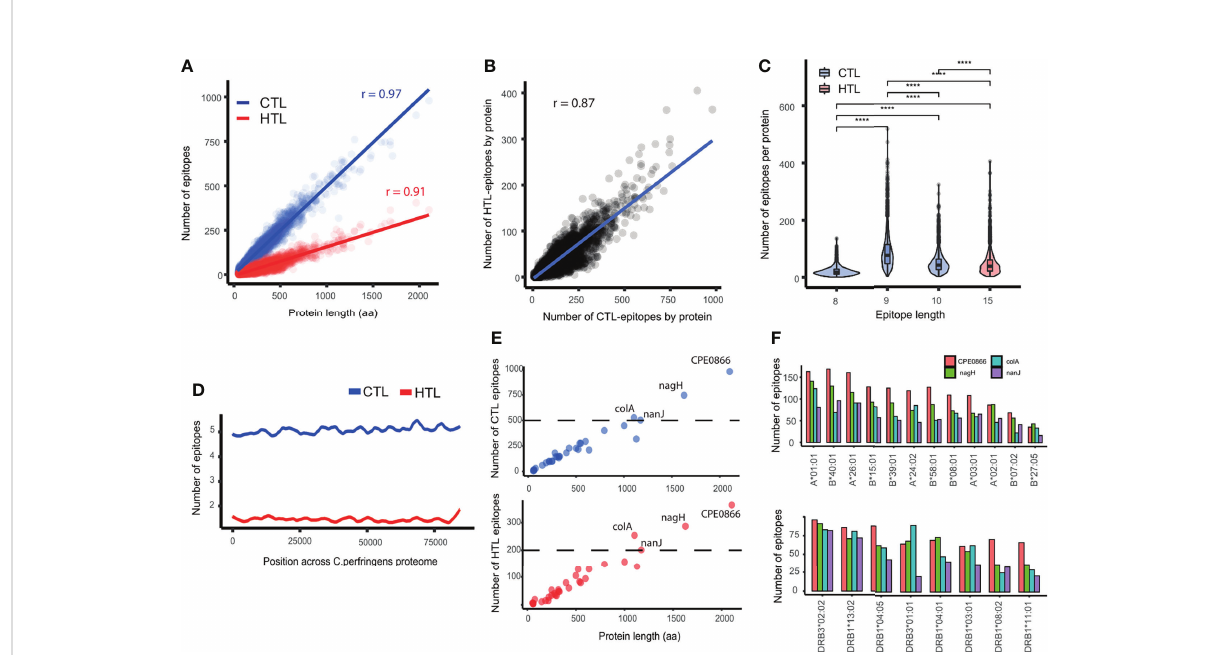
FIGURE 2 Description of the predicted epitopes in C. perfringens . (A) Correlation between the number of epitopes and protein length. Blue: CTL-epitopes. Red: HTL-epitopes. (B) Correlation between the number of HTL- and CTL-epitopes. (C) Comparison of the number of epitopes per protein, for different epitope lengths of CTL- (8, 9 and 10 aa) and HTL- (15 aa) epitopes. (D) Lasso regression of the number of CTL- (blue) and HTL- (red) epitopes across the proteome of C. perfringens . (E) Correlation between protein length and number of CTL- and HTL-epitopes in the protein (top and bottom, respectively). Proteins with more than 500 CTL- and 200 HTL-epitopes (above the dashed line) are labeled. (F) Bar plot showing the number of CTL- and HTL-epitopes (top and bottom, respectively) by HLA allele within, for the four proteins highlighted on panel (E) . **** means p-value <